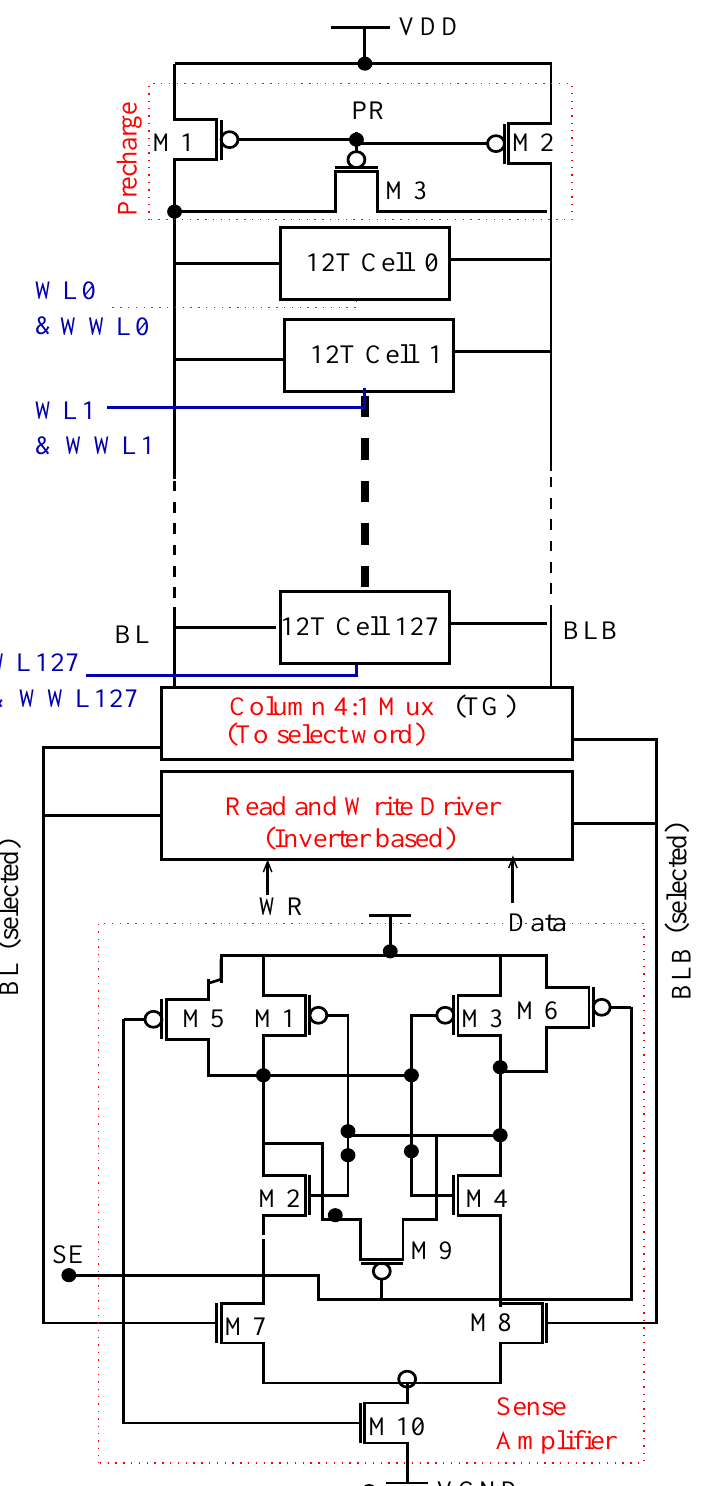
Figure 7. Proposed SRAM array and peripheral circuit, such as precharge, read–write drive, and sense